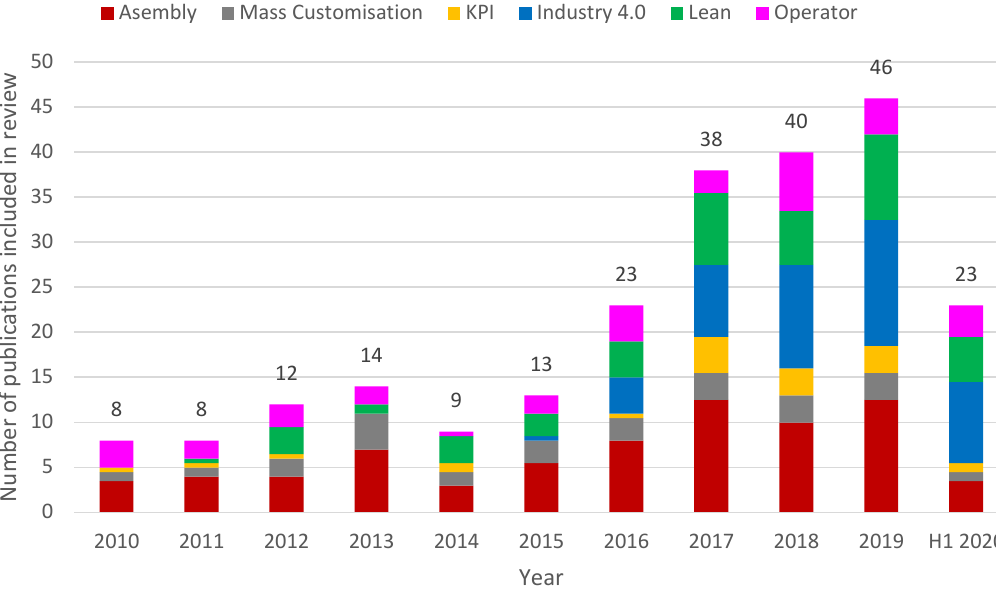
Figure 3. Publications related to each key concept, by year.